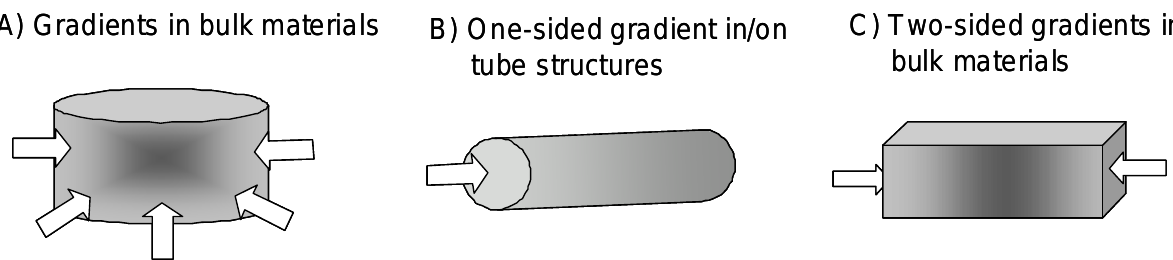
Figure 3. Applications for gradients in